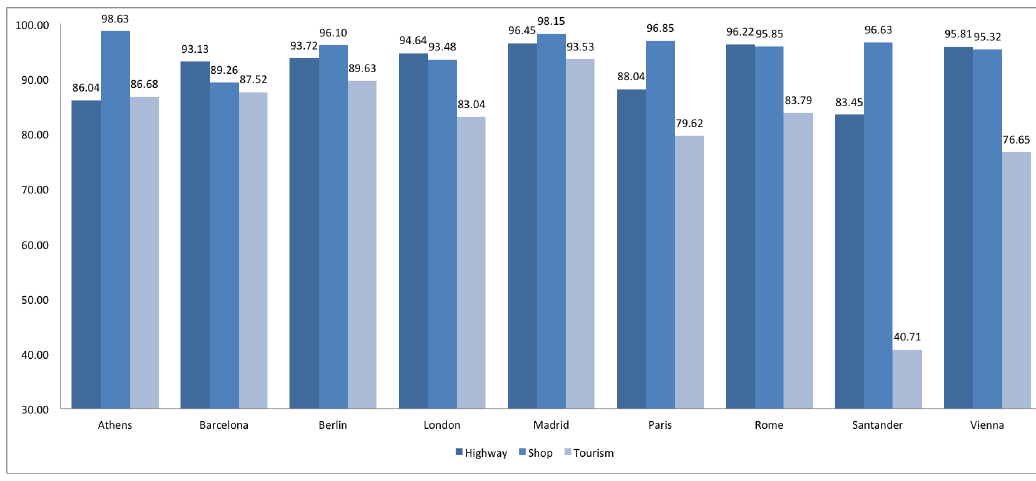
Figure 23. Compliance study in Europe. Percentage of commonly used combinations.